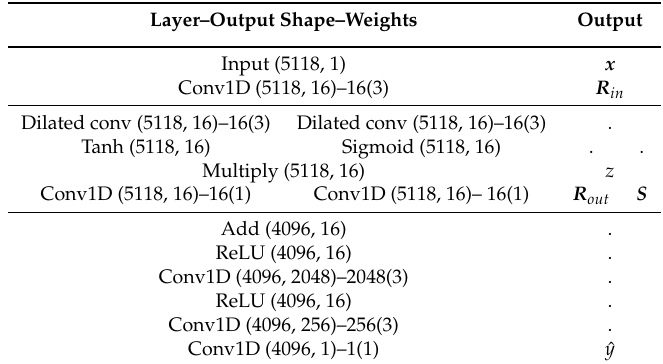
Table 3. Detailed architecture of WaveNet with input and output frame sizes of 5118 and 4096 samples respectively.